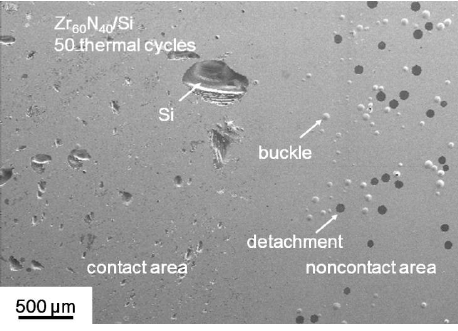
Figure 10. Surface morphology of the Zr 60 N 40 (0.4,R5)/Si assembly after 50 thermal cycles.